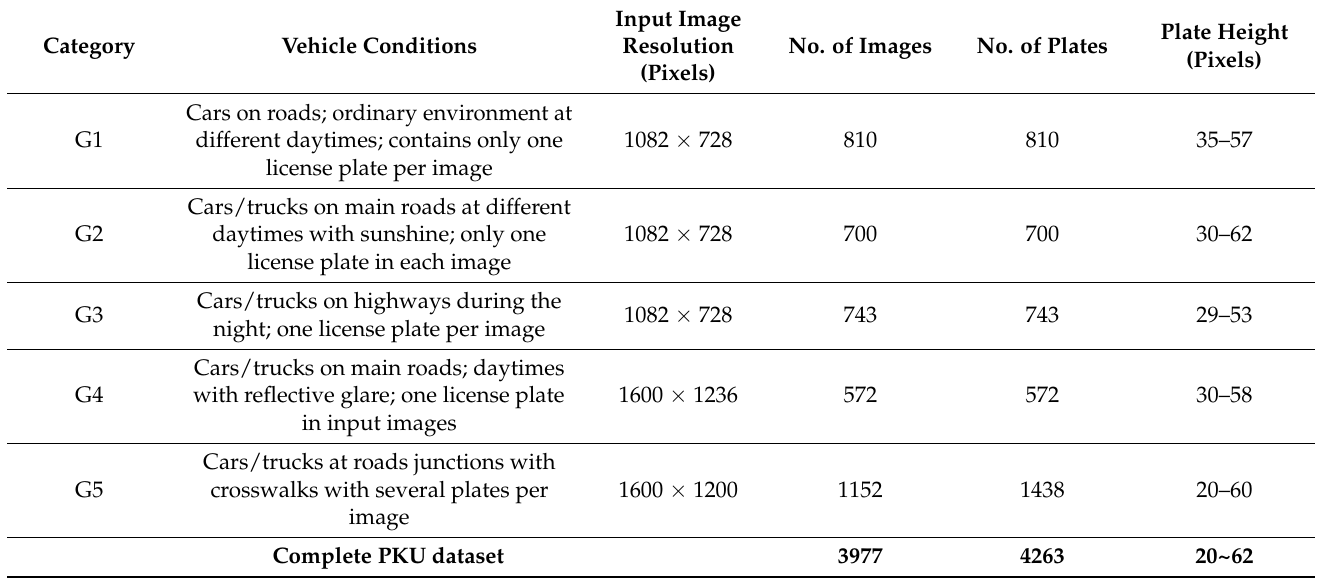
Table 1. The PKU dataset